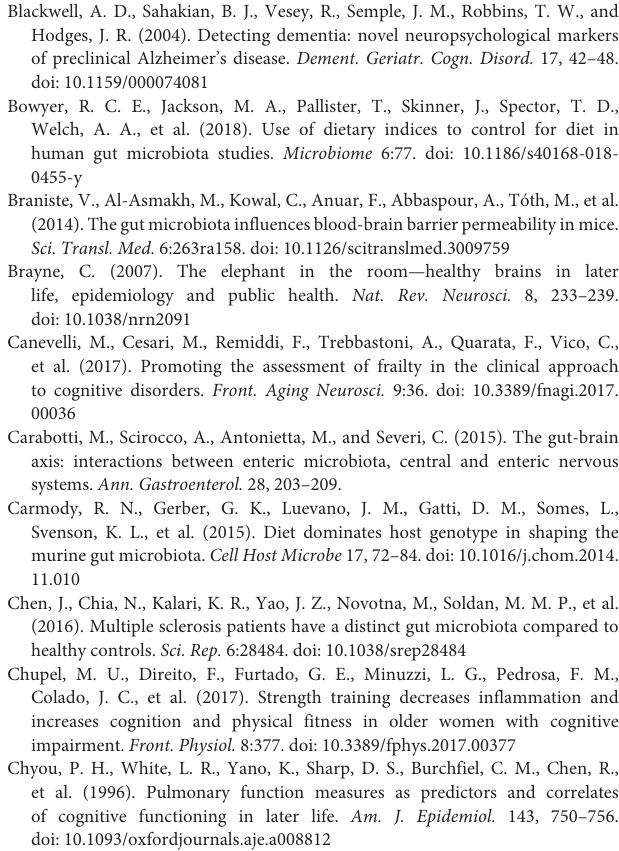
TABLE S3 | Significant results in association analyses vs.